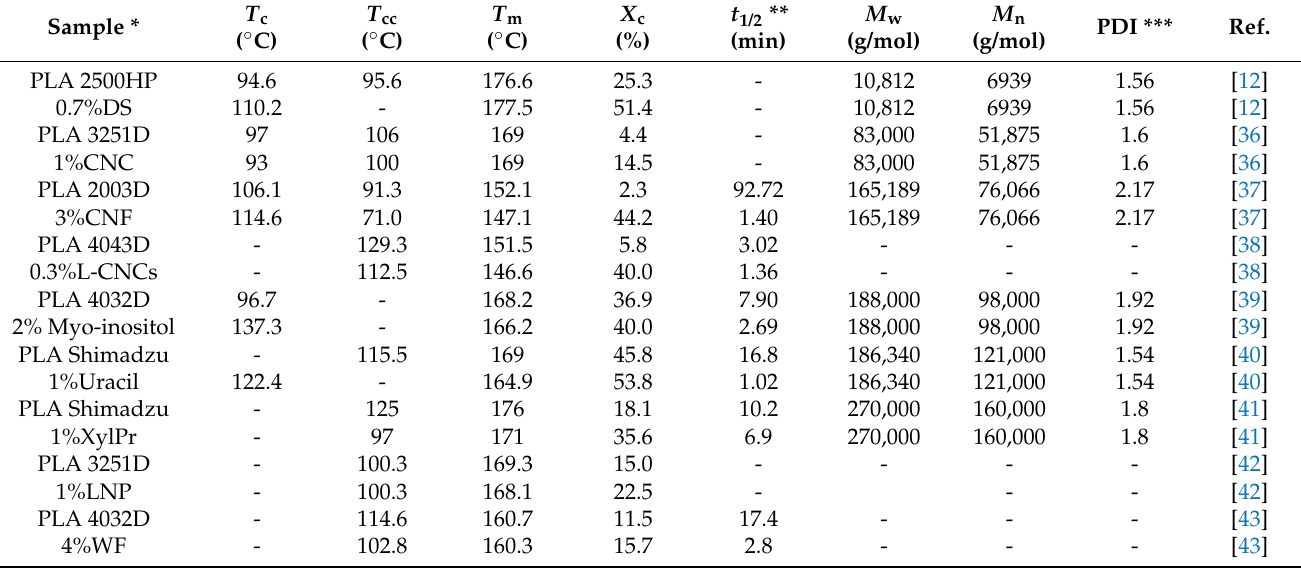
Table 2. Crystallization data of biomass nucleating agents for different PLA.